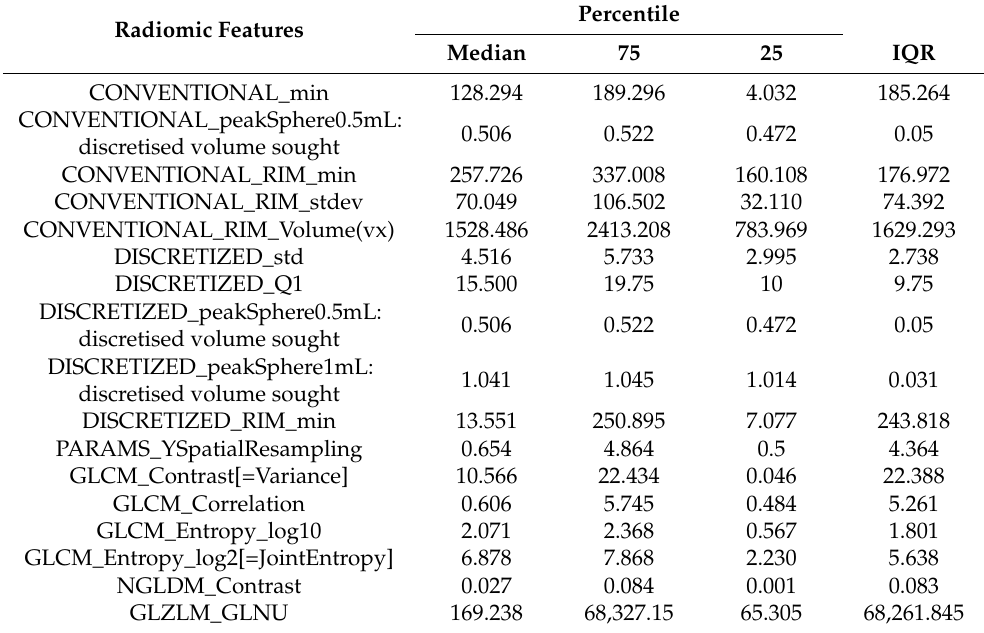
Table 1. Quartiles and IQR for the selected